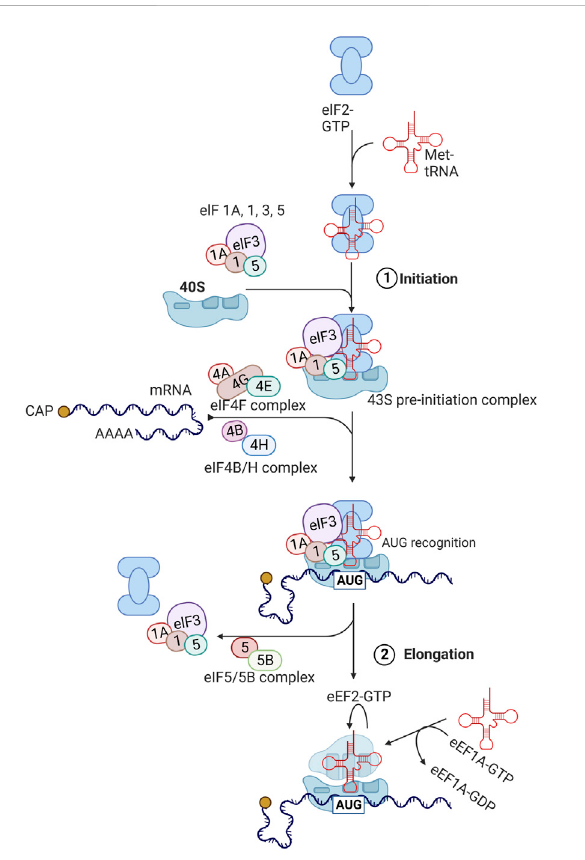
FIGURE 2 Protein translation pathways. The process of translation initiation and elongation in eukaryotic cells. Key eukaryotic initiation factors (eIFs) and eukaryotic elongation factors (eEFs) are highlighted. This process is described in detail in section 3 with involvement of highlighted factors in aging described in section 5. Created with